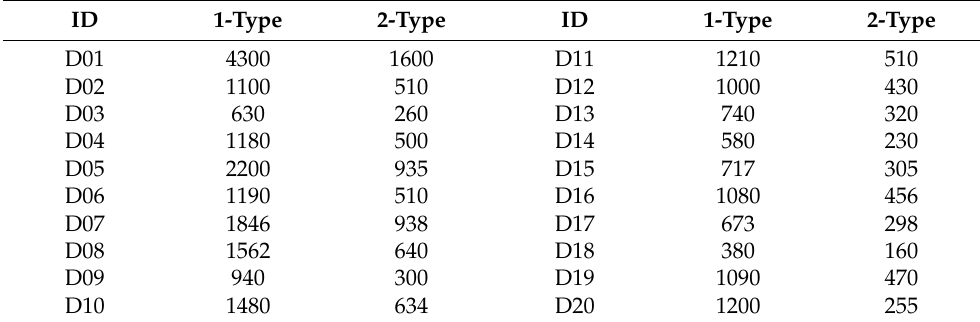
Table 5. Population data requiring evacuation.